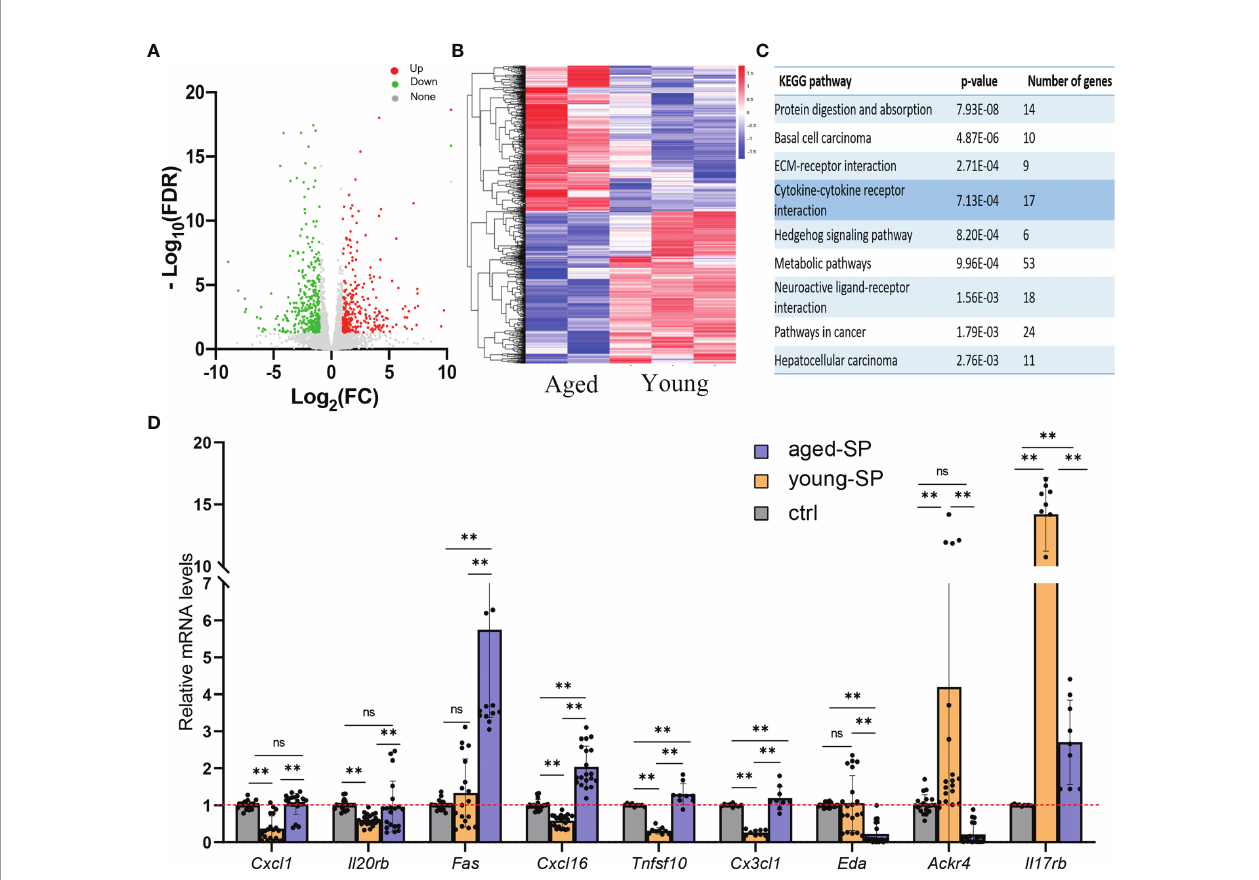
FIGURE 2 | The transcriptomics of the uteri in the young-SP group and aged-SP group. (A, B) Volcano map and heatmap depicting clustering and global changes in gene expression for the uterus from aged-SP group and young-SP group as determined by RNA-seq. (C) KEGG pathway analysis of transcripts signi fi cantly changed. Top nine most highly enriched categories are shown. (D) qPCR validation for a subset of genes involved in cytokine – cytokine receptor interaction. Gapdh served as an internal control. The differences among different groups were assessed by one-way ANOVA with Holm – Sidak post-hoc test. **p < 0.01. The p-value ≤ 0.05 and FDR q-value ≤ 0.05 were considered as statistically signi fi cant. SP, seminal plasma; KEGG, Kyoto Encyclopedia of Genes and Genomes; FDR, false discovery rate; ns, not signi fi